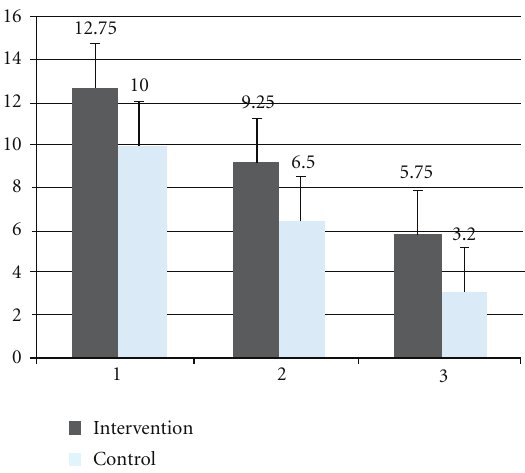
Figure 3: Mean National Institute of Health scale score, at baseline, one month and six months of the intervention and control group.